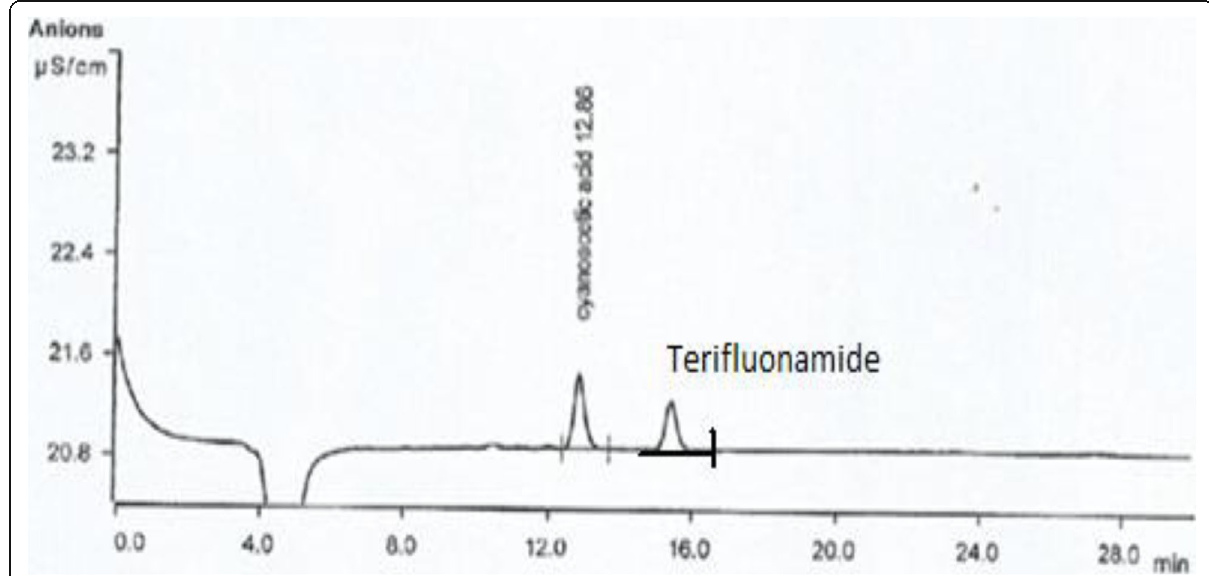
Fig. 5 A typical representative chromatogram of CAA test (spiked with